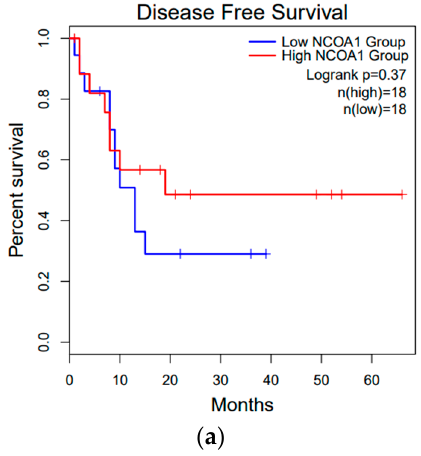
Figure 1. Expression of five selected mitochondrial proteins in CCA and normal tissues. ( a ) Venn-diagram demonstrating six mitochondrial proteins uniquely expressed in CCA dataset. ( b–f ) Gene expression levels of five candidate proteins in CCA and normal tissues were retrieved from the GEPIA2 database. NCOA1 (nuclear receptor coactivator 1 isoform 3), AIFM3 (apoptosis-inducing factor, mitochondrion-associated 3), VCP (transitional endoplasmic reticulum ATPase), CIAPIN1 (cytokine-induced apoptosis inhibitor 1), PICK1 (PRKCA-binding protein), and PPID (peptidyl-prolyl cis-trans isomerase D), T: tumor (red box), N: normal (grey box). * Statistically significant difference with p < 0.01.